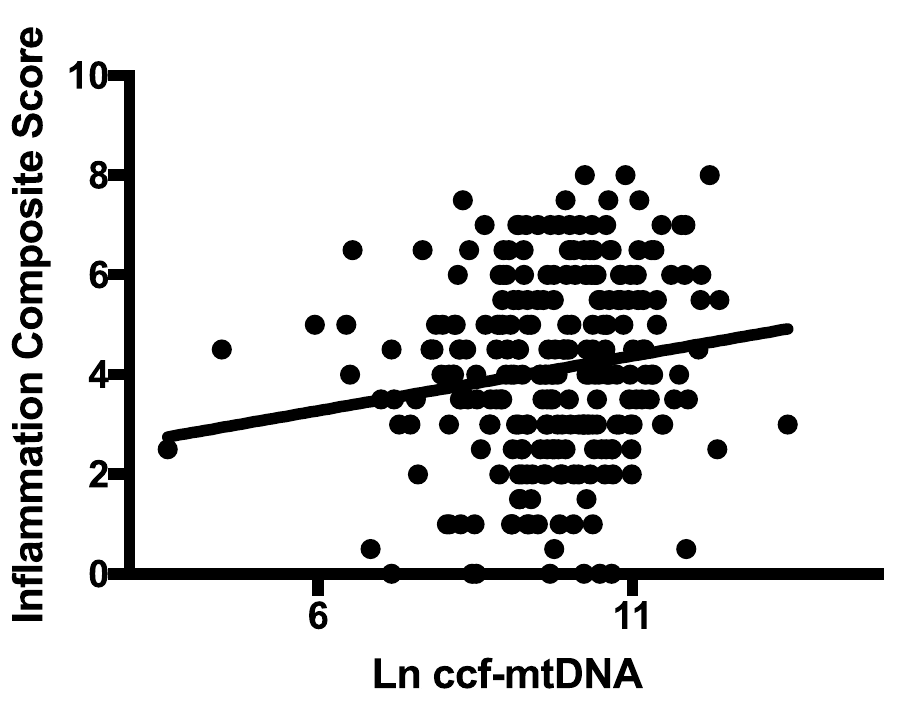
Fig 2. Correlation between ccf-mtDNA and “inflammation composite score” calculated by summarizing CPRS- items “lassitude”, “fatiguability”, “reduced appetite” and “reduced sleep”. Both patients with current and remitted depression were included. The correlation was significant (r = 0.15, p = 0.02, df = 264, adjusting for age and sex).